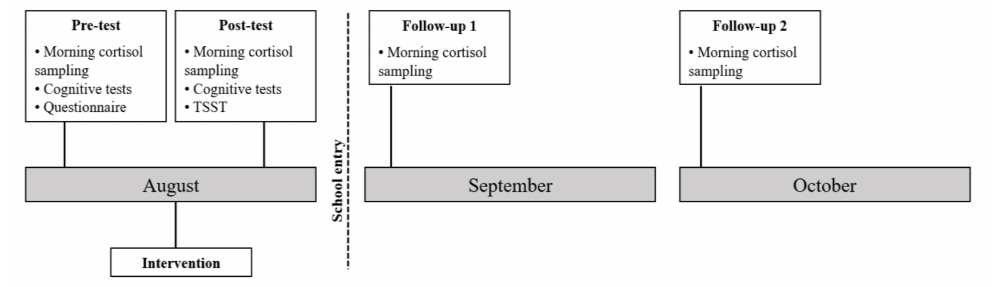
Figure 2. Timeline of the